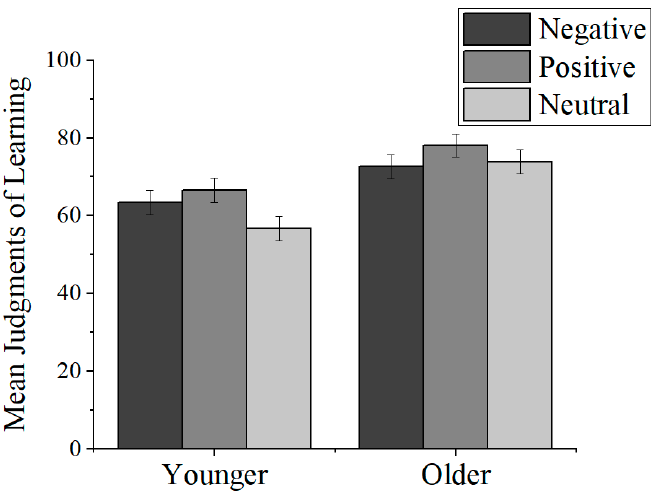
Figure 1. Mean judgments of learning (JOLs) responses by valence for younger and older adults (with standard error bars).